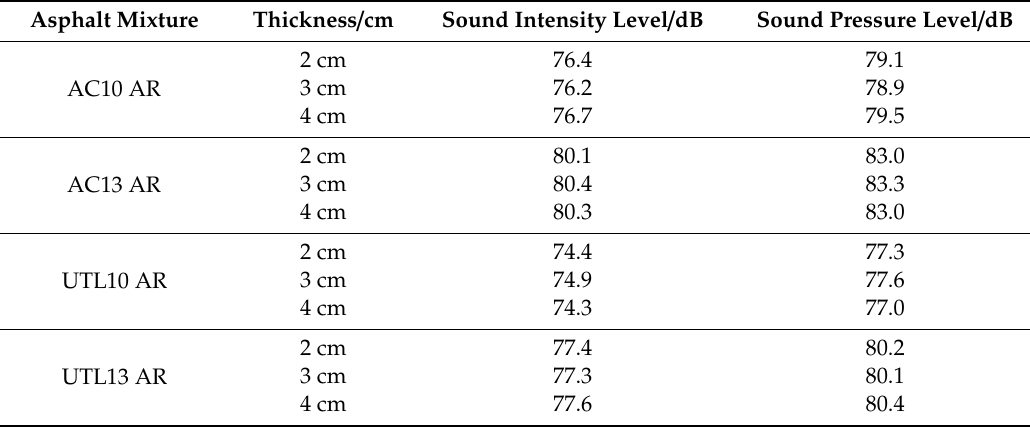
Table 7. Noise test results of asphalt mixture with di ff erent mixture